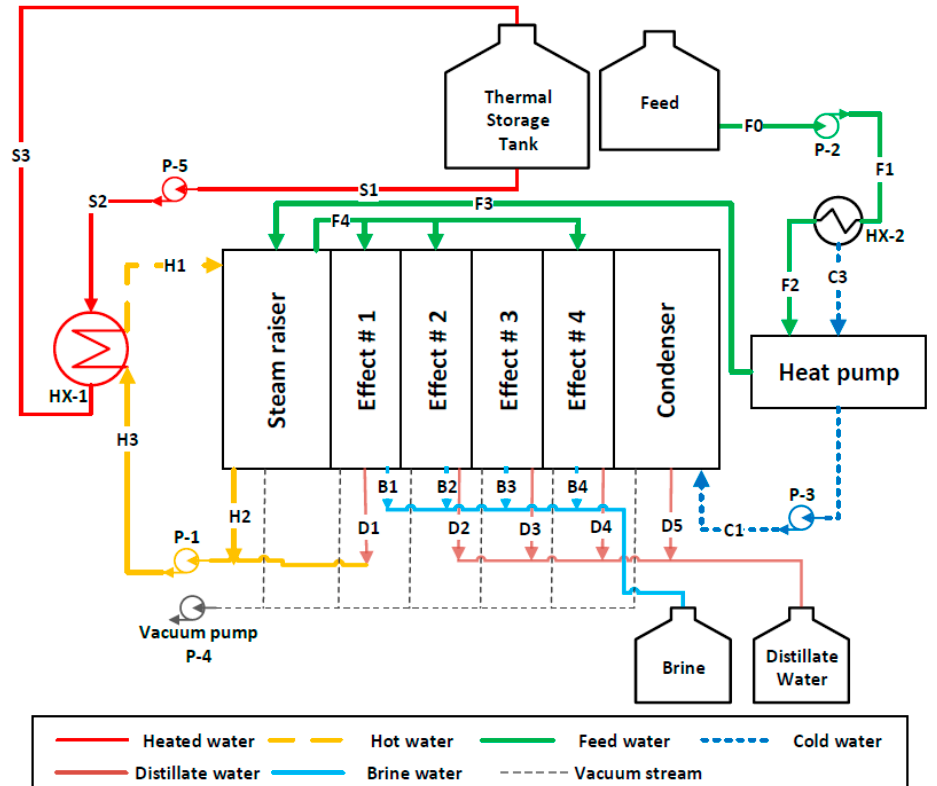
Figure 4. V-MEMD system under cross-flow configuration.